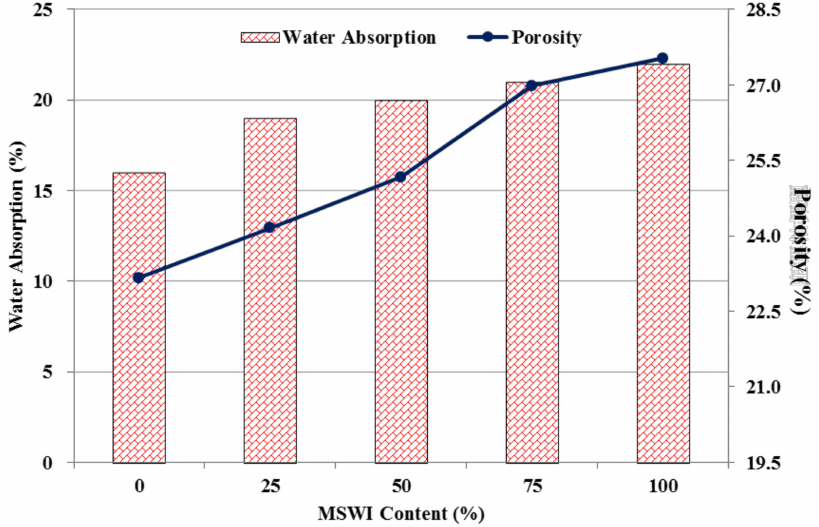
Figure 6. Effect of MSWI content on water absorption and